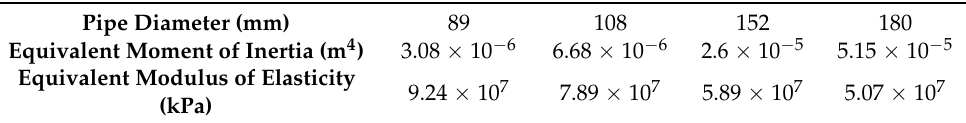
Table 2. Combined section parameters of different pipe diameters.